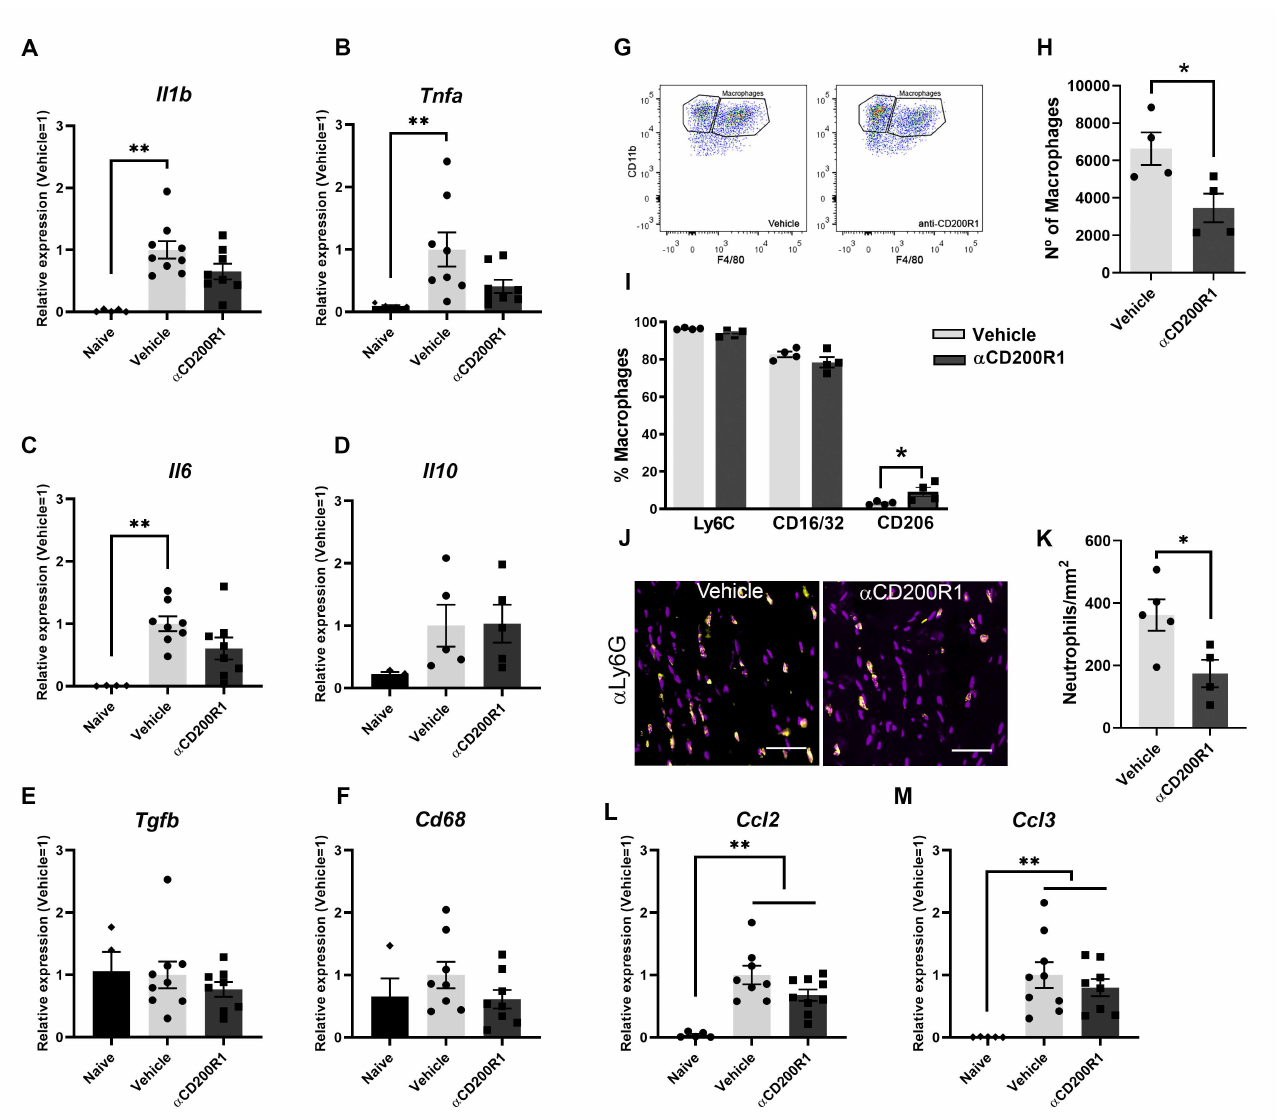
Figure 4. Blockade of CD200R1 reduces monocyte and neutrophils infiltration at 24 h post-injury. QPCR shows a significant increase in several cytokines at one day post-injury with no differences between treatments ( A – F ) (Non-parametric Kruskal–Wallis test followed by Dunn’s post-hoc test; ** p ≤ 0.01 vs. Naive group). Representative FACS dot blots of crush sciatic nerve show the gating for macrophages ( G ). Quantification of the total number of macrophages at one day post-injury evaluated by FACS analysis and the percentage of macrophages expressing markers of activation as Ly6C, CD16/32 and CD206 ( H , I ) (Student t-test; * p ≤ 0.05 vs. Vehicle). Representative micrographs of sciatic nerve immunolabeled against Ly6G at 1 dpi (Scale bar: 100 µ m) ( J ) and quantification of the number of Ly6G positive cells ( K ). QPCR quantification of the chemokines Ccl2 and Ccl3 at 1 dpi ( L , M ) (Non-parametric Kruskal–Wallis test followed by Dunn’s post-hoc test; ** p ≤ 0.01 vs. Naive